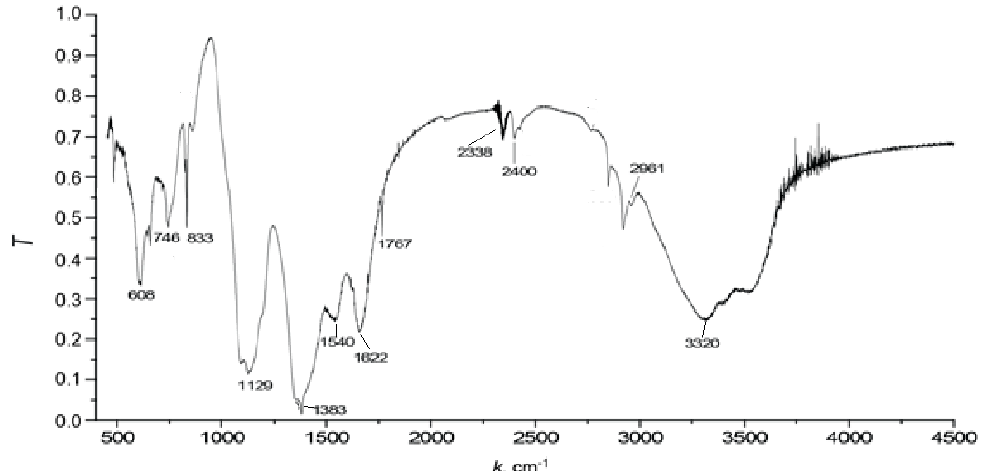
( b ) Figure 3. Surface microstructure of C. sorokiniana biomass after lyophilization: ( a ) external view; ( b )